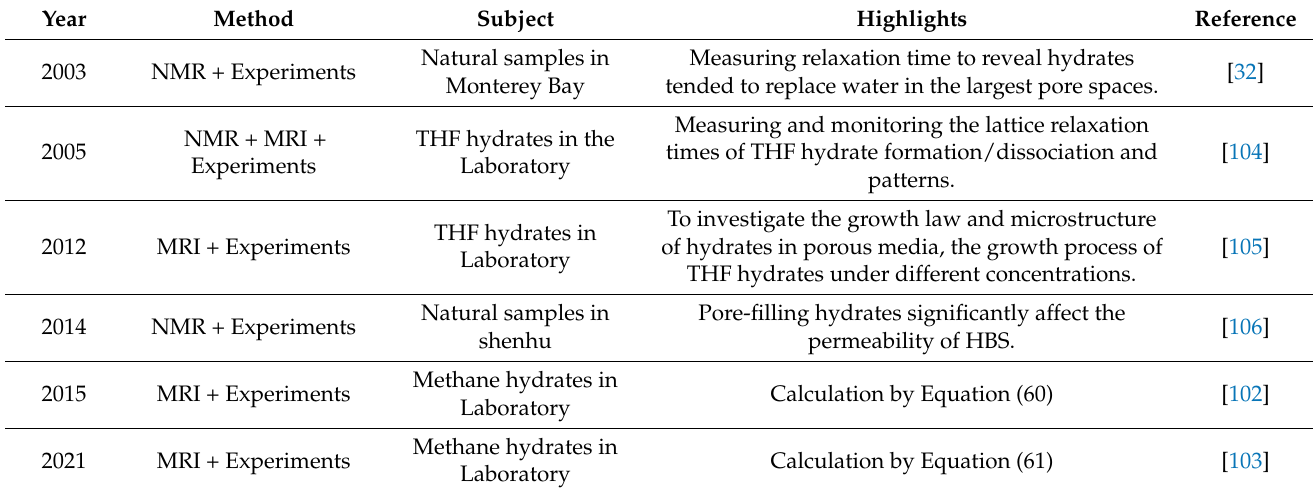
Table 5. The seepage characteristics of NMR/MRI technique on hydrate